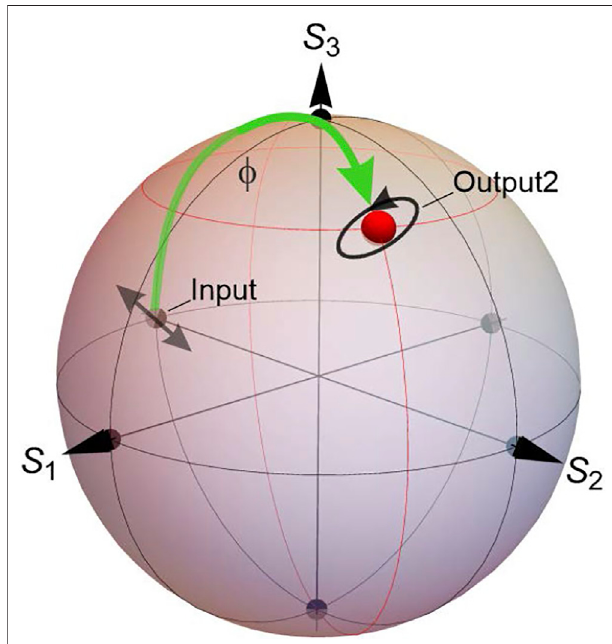
FIGURE2| Demonstrationofthephaseshift ϕ inthecourseofthebeam evolution (visualization with the help of the Poincaré sphere).